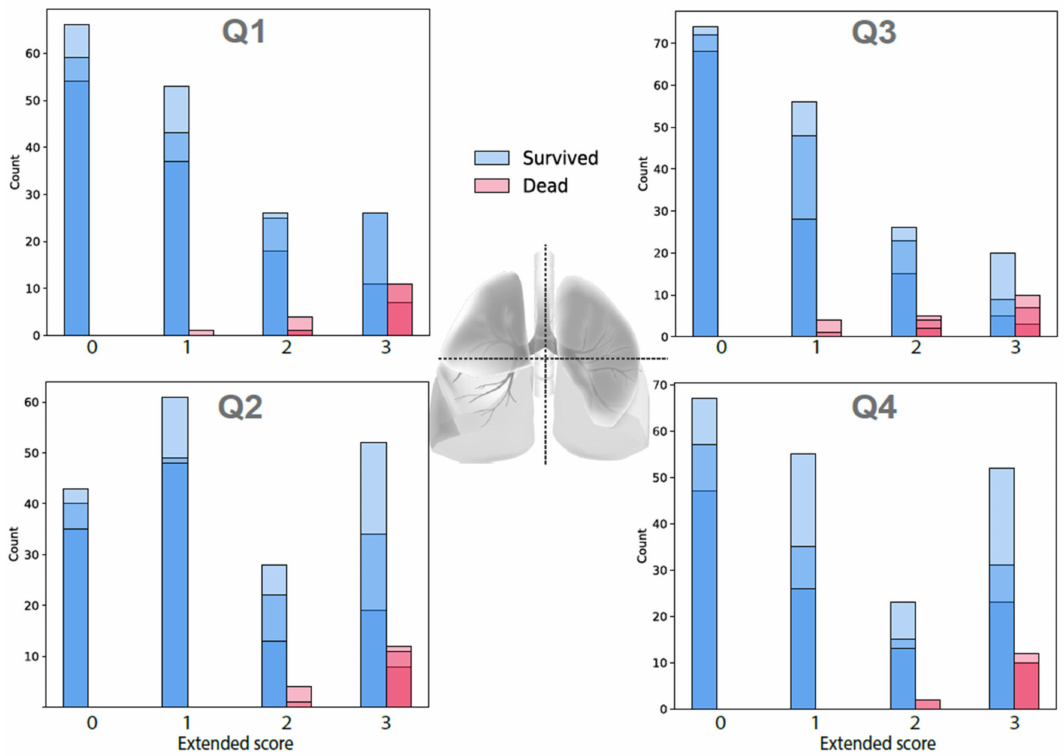
Figure 1. Distribution of CXR score values in surviving and dead groups. The blue and red color different was marked by the scoring of each one among 3 radiologist